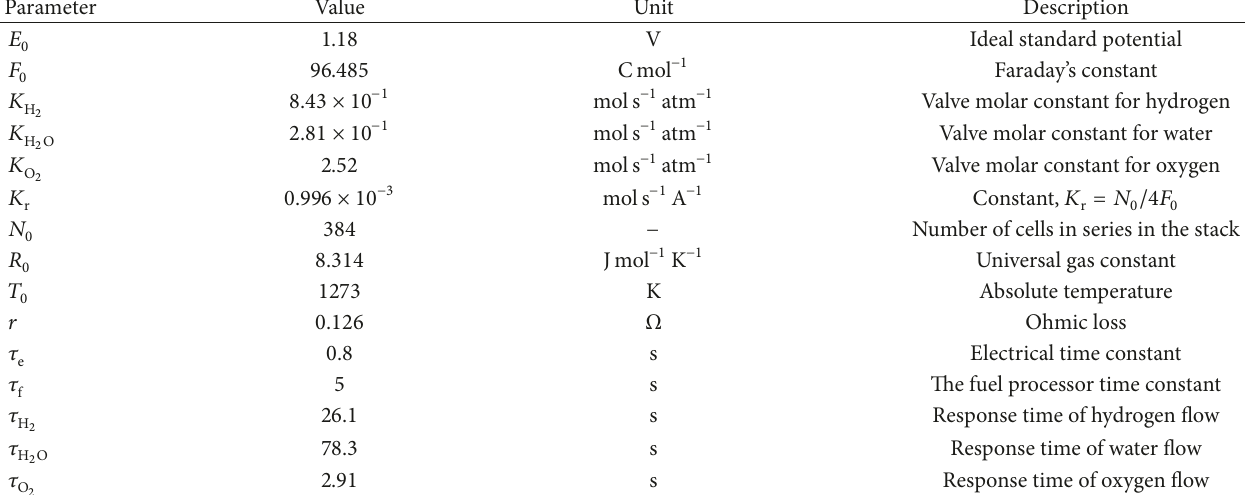
Table 1: Parameters of the fundamental continuous-time model of the SOFC system.